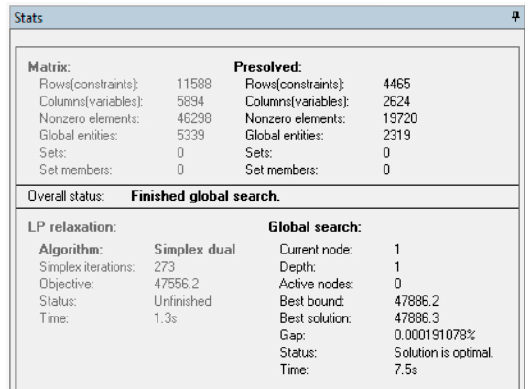
Figure 5. Reports from Xpress-IVE